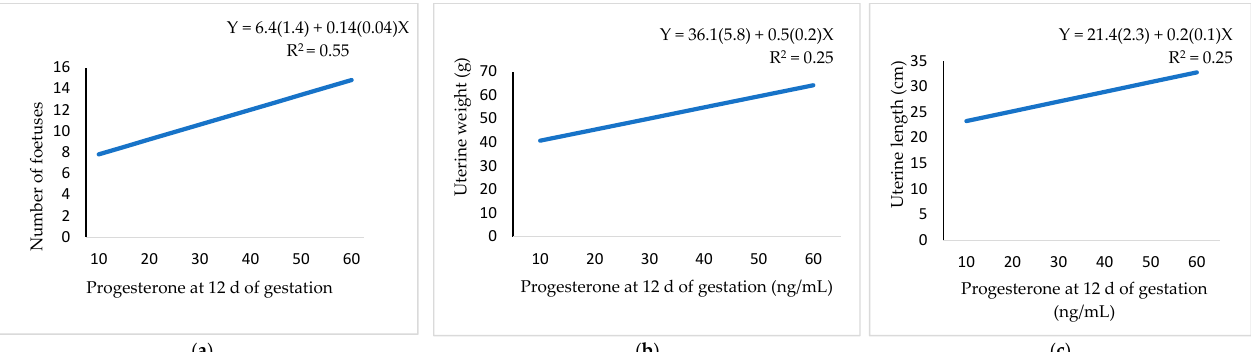
Figure 4 . Regression equation (standard error between brackets) at 12 d of gestation for the relationship between progesterone and: ( a ) number of foetuses; ( b ) uterine weight; ( c ) uterine length.